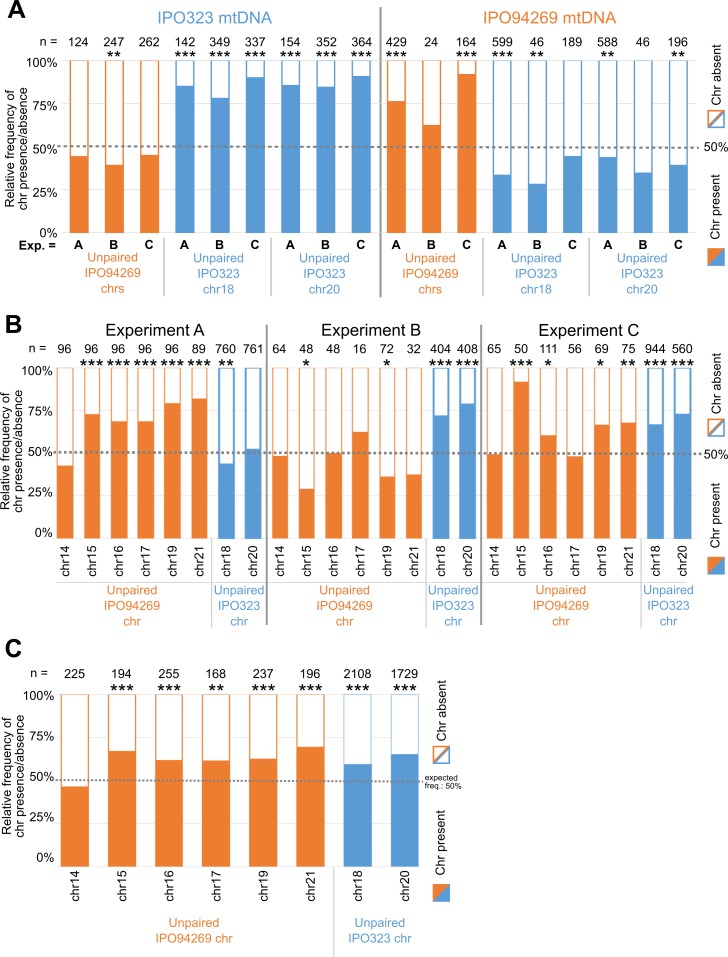
Transmission of unpaired chromosomes and mitochondria.(A) Detailed presence/absence frequencies for all unpaired supernumerary chromosomes according to the mitochondrial genotype present in all ascospores. Data for the three experiments A, B and C are depicted separately. Statistical significance was inferred by a two-sided binomial test with a probability of p=0.5. (B) Detailed presence/absence frequencies for all unpaired supernumerary chromosome in experiment A, B and C, restricted to all co-inoculation crosses using 1*107 cells/mL cell density for both parental strains. Experiment A, B and C differ in the observed transmission advantage for the chromosomes originating from the parent IPO94269 (orange) or IPO323 (blue). Statistical significance was inferred by a two-sided binomial test with a probability of p=0.5. (C) Presence/absence frequencies of all unpaired supernumerary chromosomes pooled for all three experiments A, B and C, restricted to all co-inoculation crosses using the 1*107 cells/mL cell density for both parental strains. All supernumerary chromosomes, with the exception of chromosome 14 show a highly significant transmission advantage. Statistical significance was inferred by a two-sided binomial test with a probability of p=0.5. (*=p < 0.05, **=p < 0.005, ***=p < 0.0005, see Supplementary file 5 for details on all statistical tests).